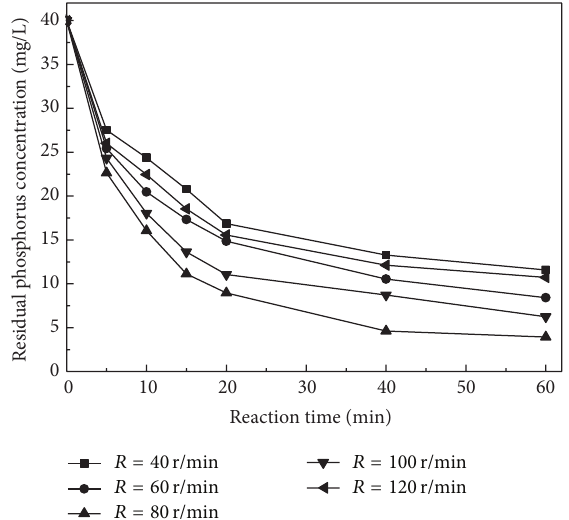
Figure 6: Influence of dosage of amorphous ceramics.